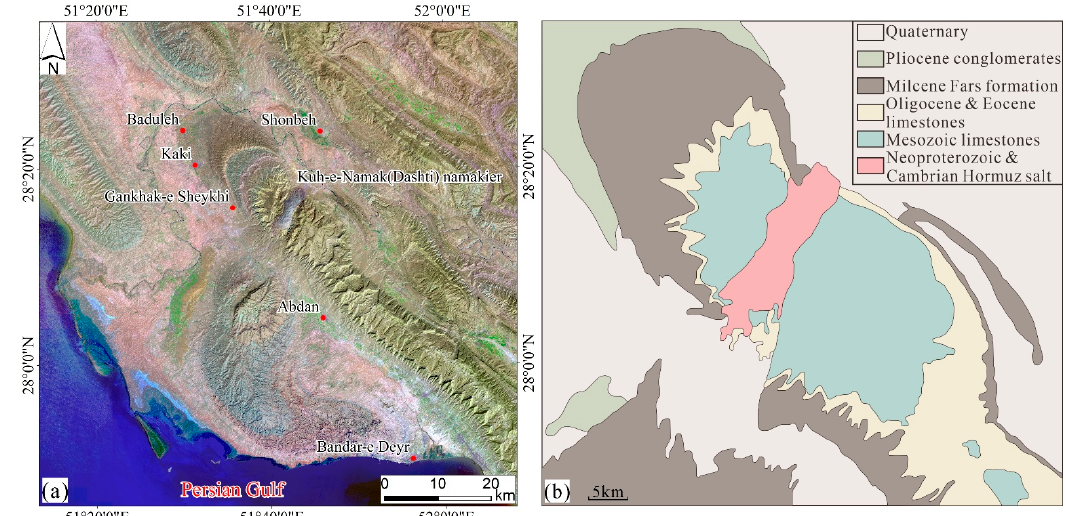
Figure 1. ( a ) Location of Kuh-e-Namak (Dashti) namakier; and ( b ) geological map of Kuh-e-Namak (Dashti) namakier (modified from [37]).